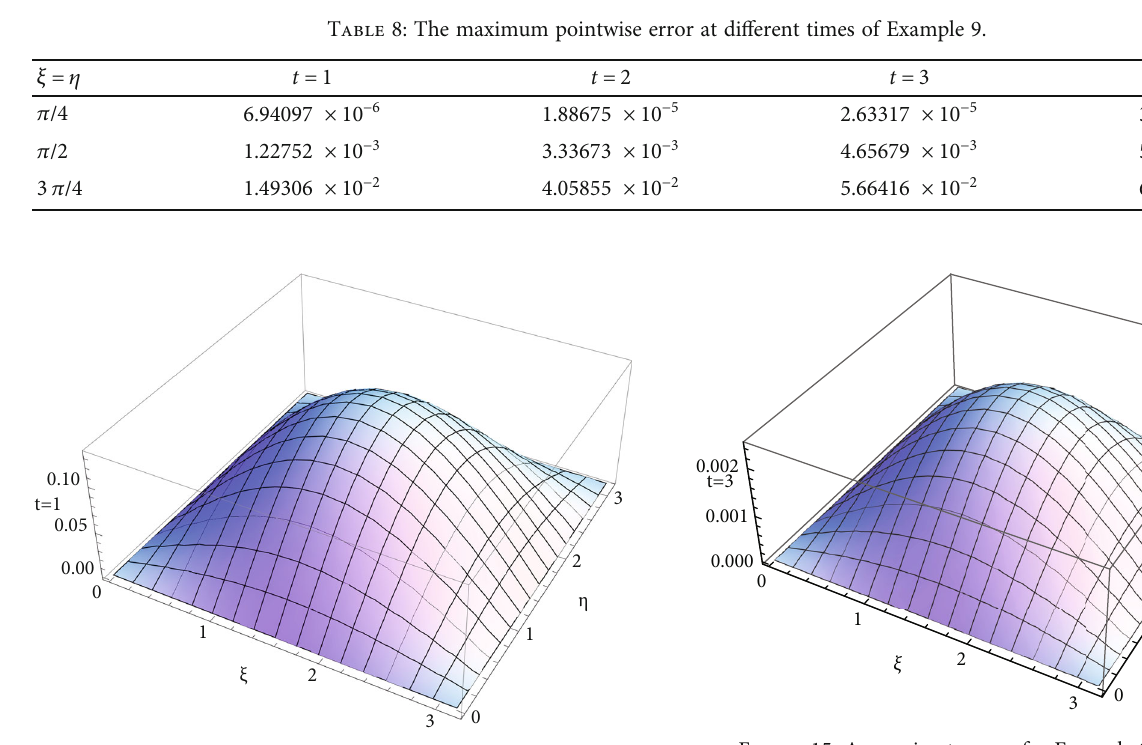
Figure 13: Approximate solution for Example 9 at t=1.